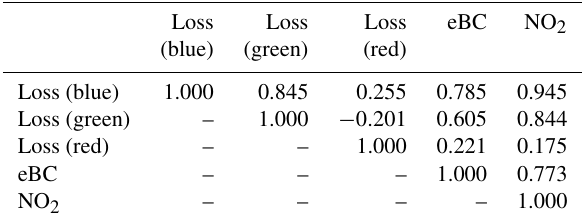
Table 1. Correlation coefficients of the loss values of the three CAPSs (450, 530 and 630nm), and the eBC and NO 2 concentra-